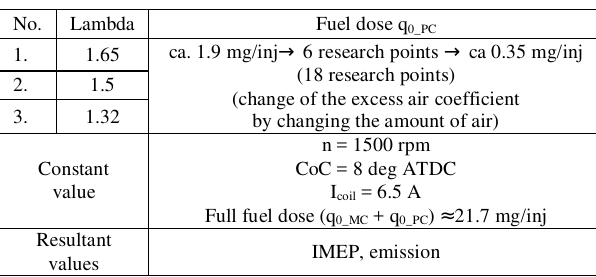
Table 4. Pre-selection of test points